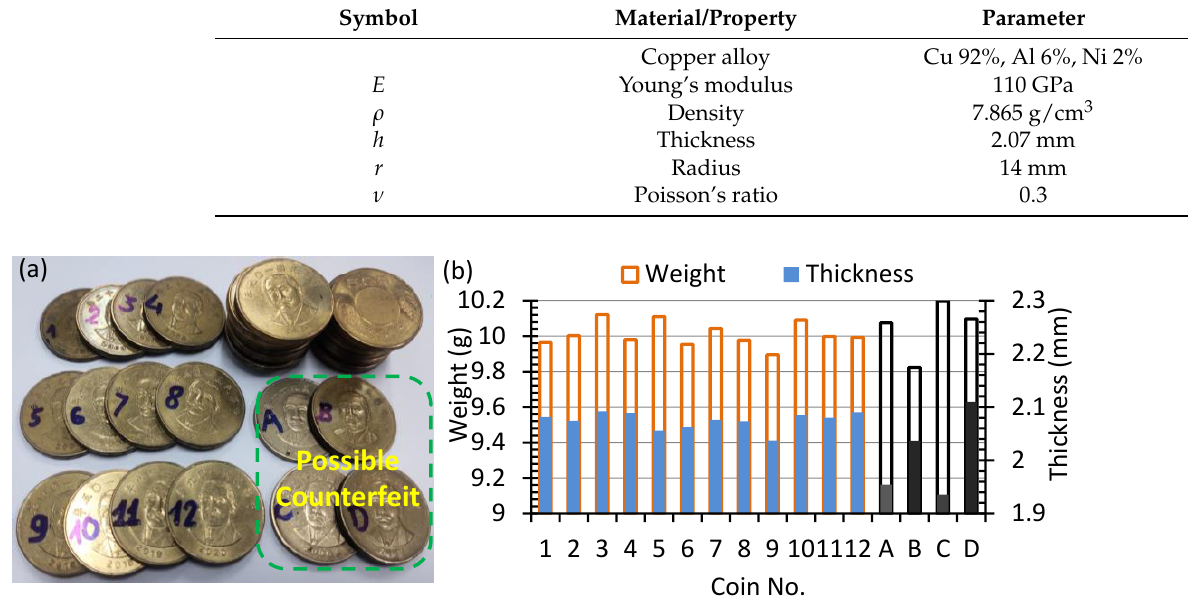
Figure 4. ( a ) The 50 NTD coin specimens used in this work; ( b ) weight and thickness distribution of the coin.